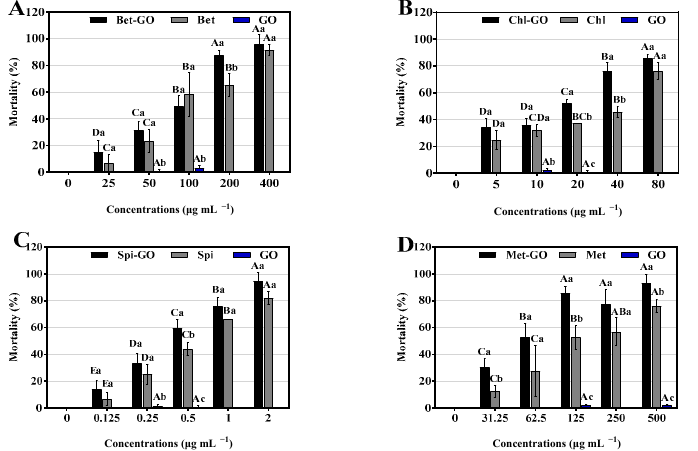
Figure 7. The synergistic effect of GO on the control of the third instar larvae of S. frugiperda by Bet ( A ), Chl ( B ), Spi ( C ) and Met ( D ). Different lower case letters indicate significant differences between treatments within the same concentration; different capital letters indicate significant generational differences at the same treatment level (Fisher’s protected LSD test, p < 0.05). Data are mean ± standard error (SE). Error bars represent the SE (N = 3).